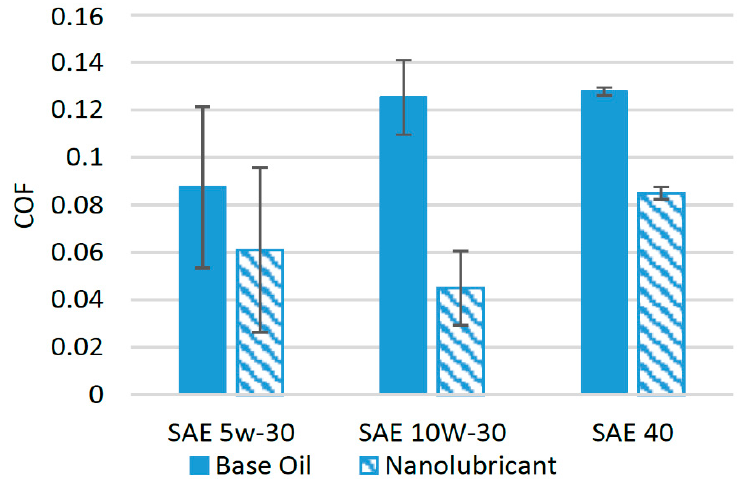
Figure 3. Effect of TiO 2 NPs on the friction performance of synthetic